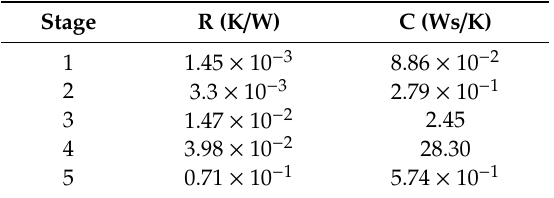
Figure 2. Four-stage Cauer topology RC thermal network representation of the IGBT device used for the transient simulation. Table 1. Thermal RC model (Cauer) parameters of the example IGBT.